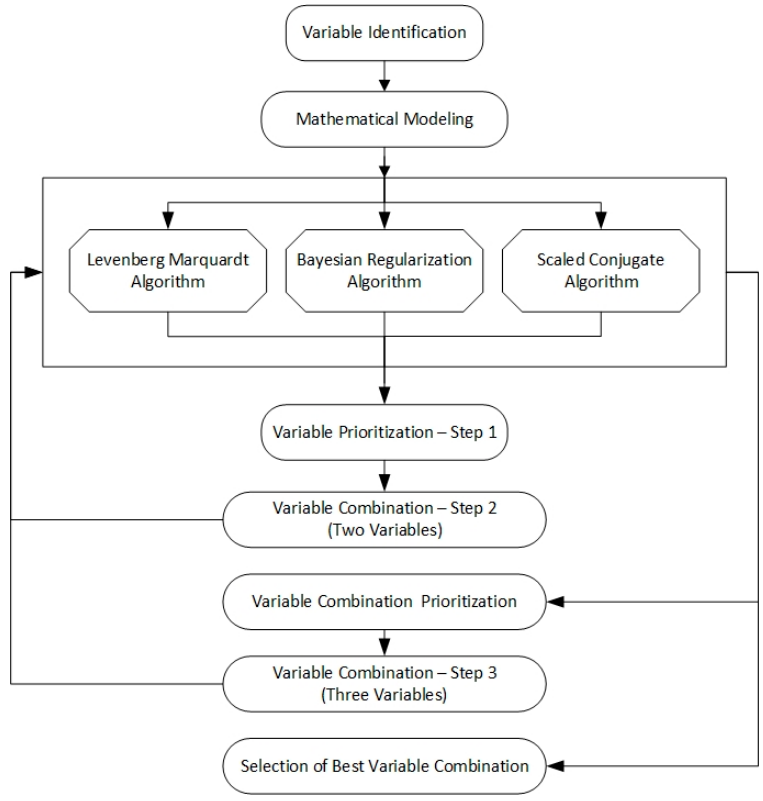
Figure 1. Schematic diagram of the methodology.